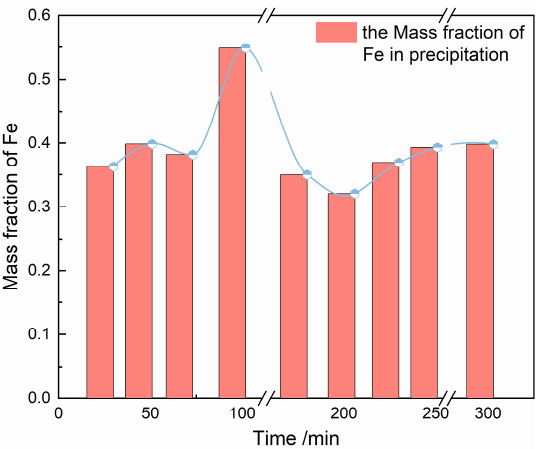
Table 5. Composition of produced precipitate under different time.